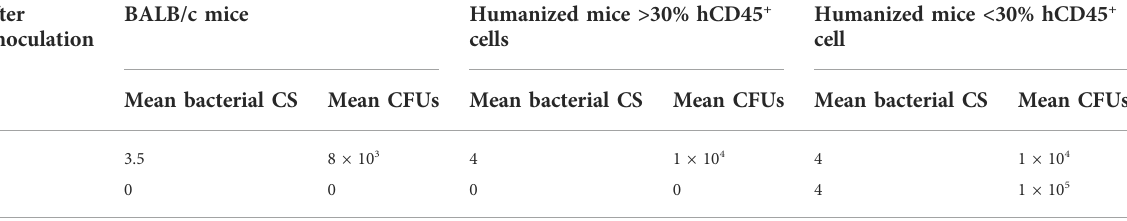
TABLE 1 Bacterial clearance of middle ears for different mice strains through the experimental time course of OM. Time after NTHi inoculation